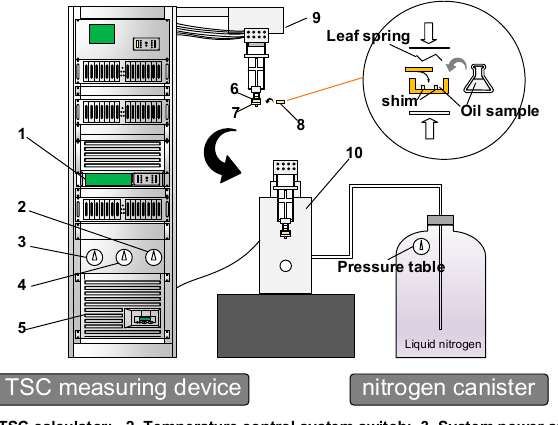
Figure 3. Thermally stimulated current (TSC) measurement system.